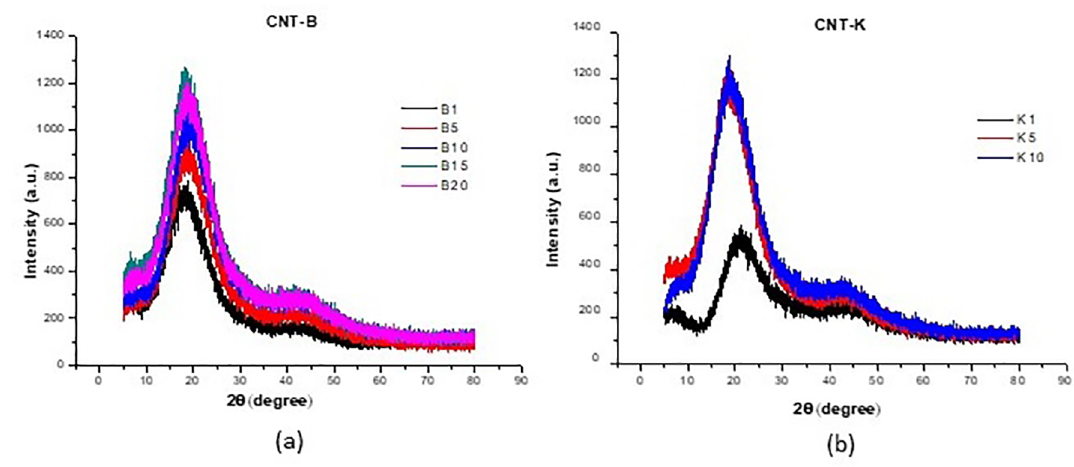
Figure 6. XRD patterns of nanostructured composites Table 3. Crystallographic parameters (2θ, L composites.